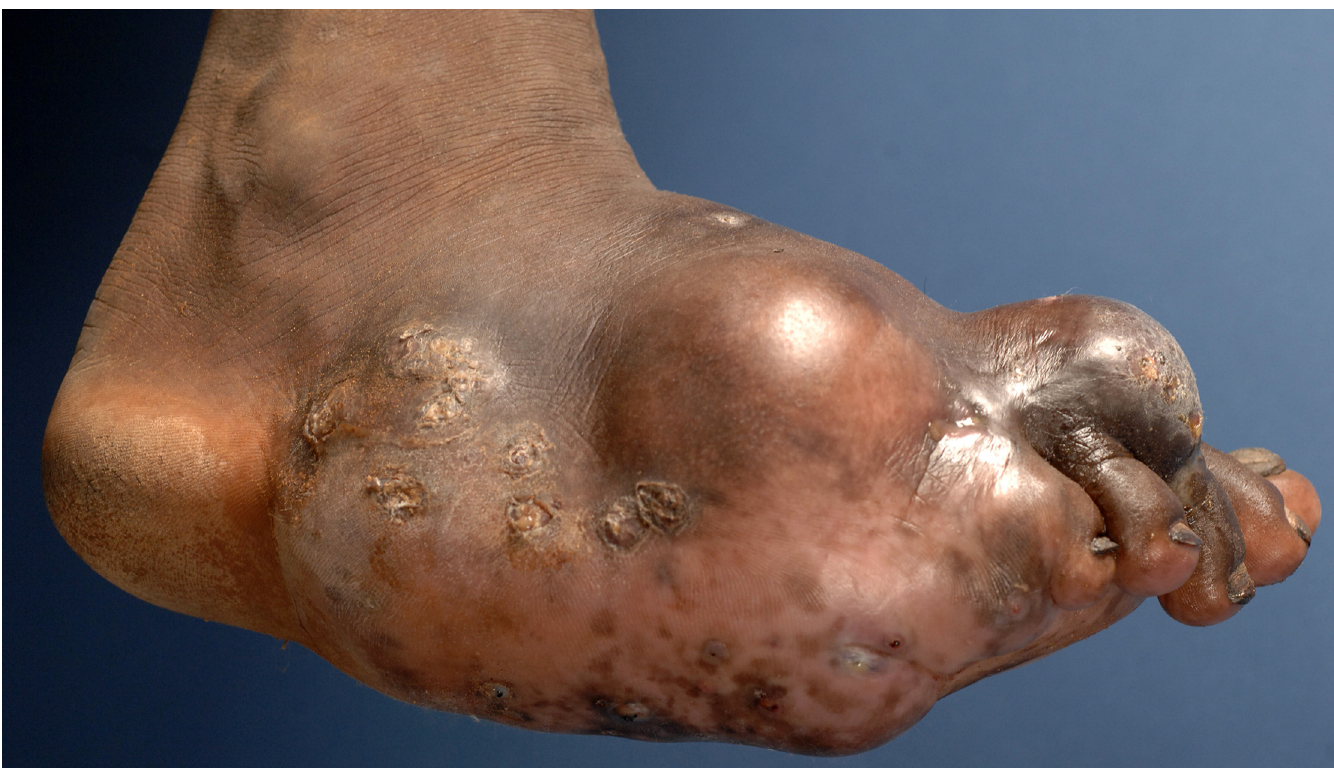
Fig 1. Photograph showing massive foot eumycetoma caused by Madurella mycetomatis